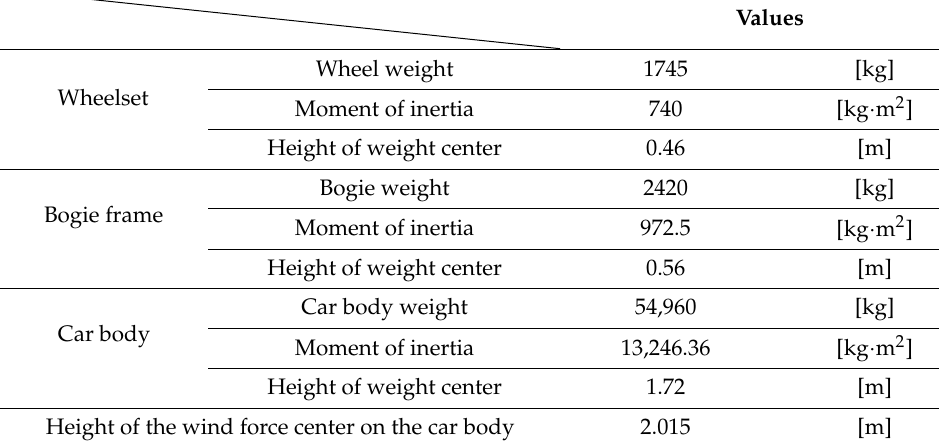
Table 5. Input data for 2D simulations.